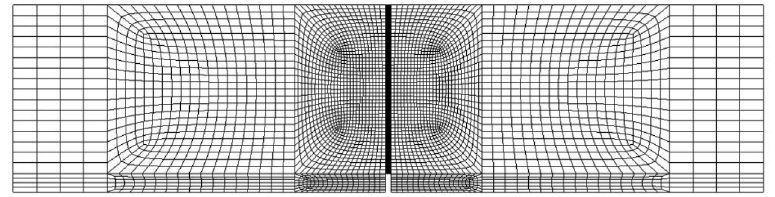
Figure 9. Finite element meshes of the notched beam in FEM analysis.